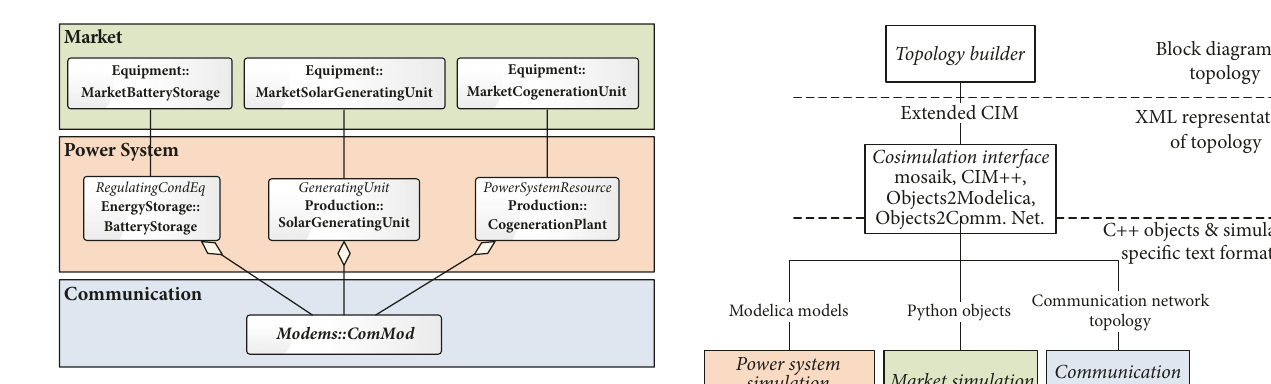
Figure 2: Interdomain connections between classes of power sys- tem, communication network, and market.